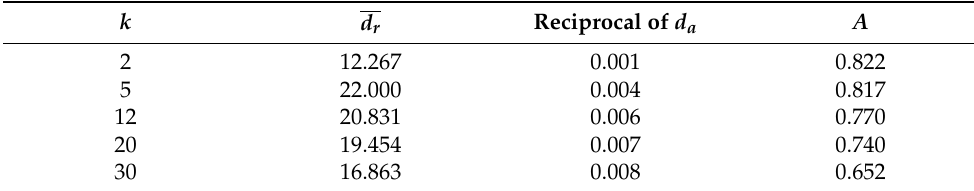
Table 5. The nondominated solutions on the Pareto